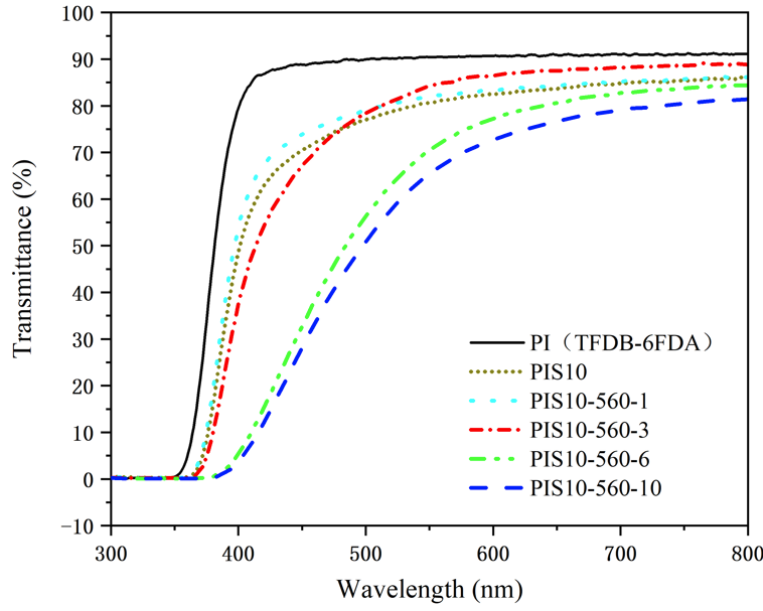
Figure 3. The transmittance of PI, PIS10, PIS10-560-1, PIS10-560-3, PIS10-560-6 and PIS10-560-10.